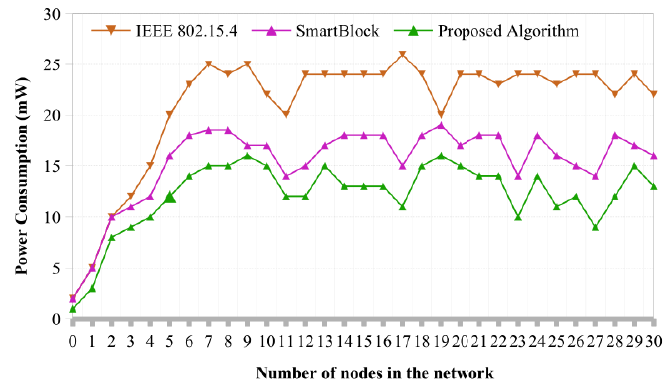
Figure 5. Power consumption of cluster head selection algorithm.